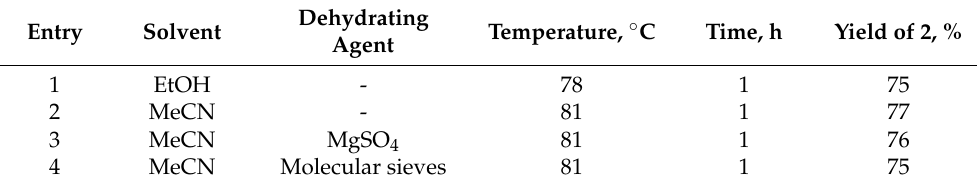
Table 1. Reaction of 3,6-dibromopyridazine-4,5-diamine 1 with SeO 2 .